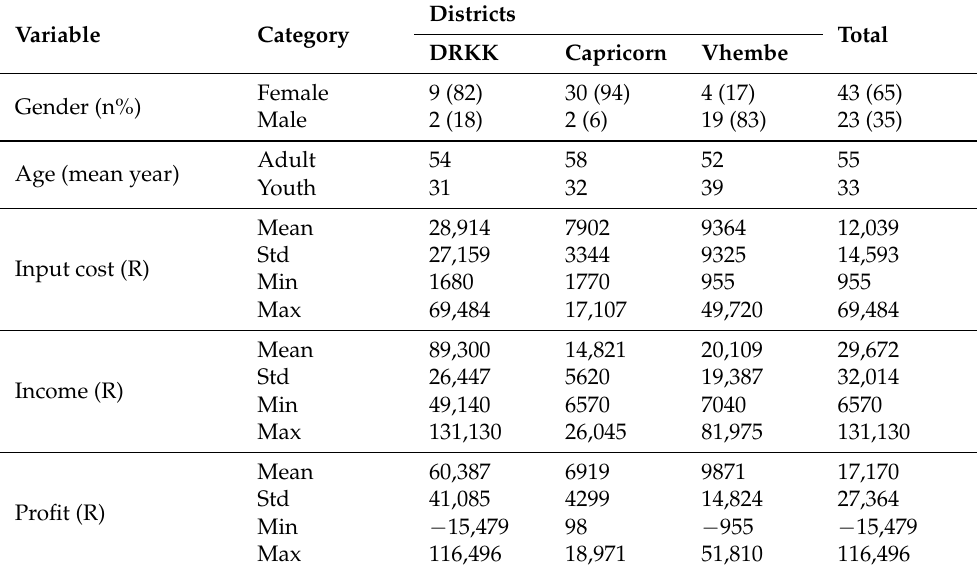
Table A1. Socioeconomic profiles of the sampled